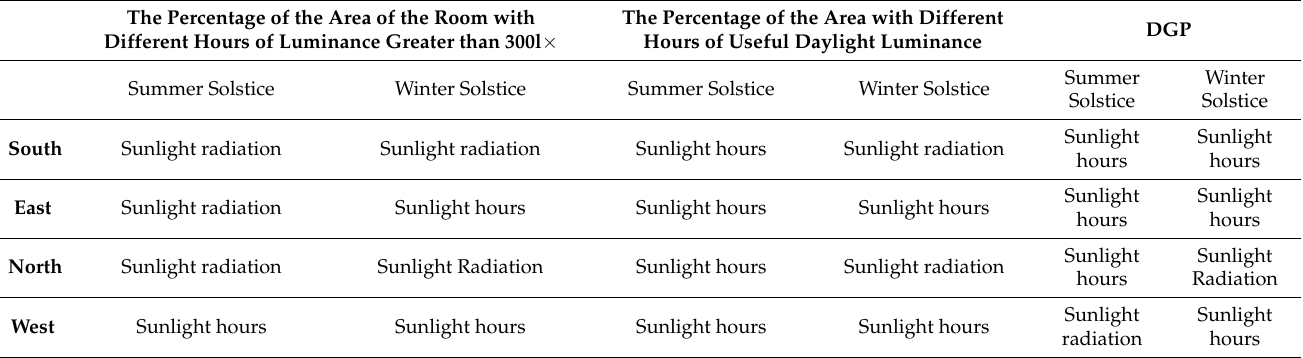
Table 5. Photothermal parameters with a positive improvement in environmental lighting per- formance (self-developed).